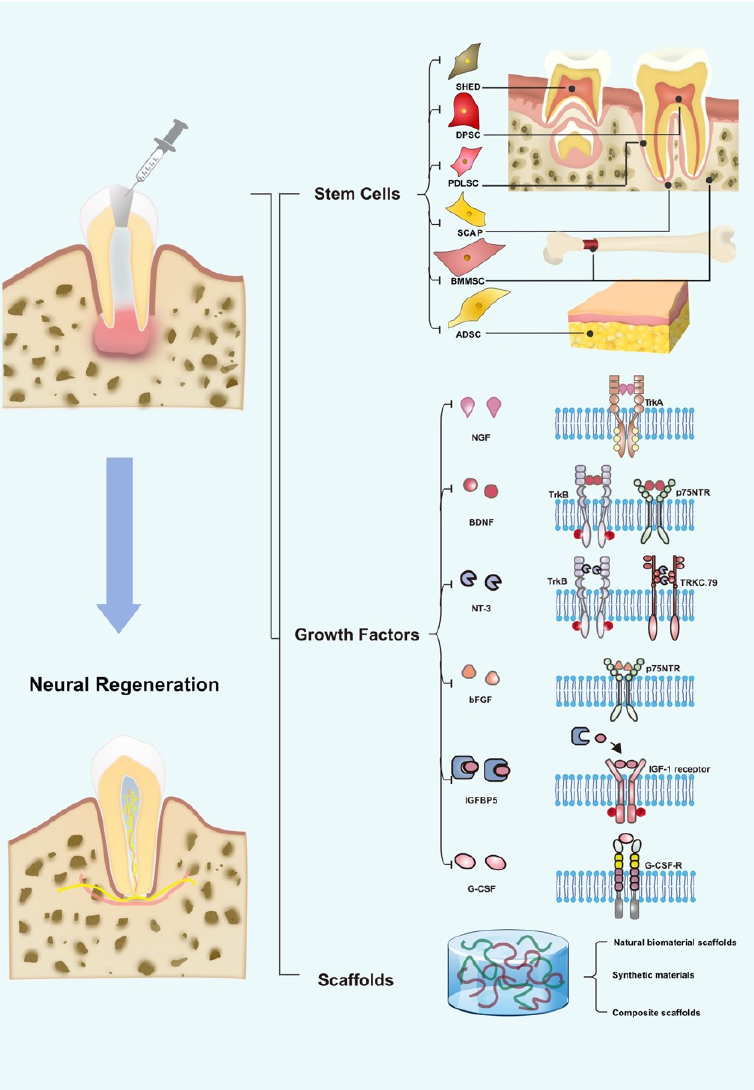
Figure 2. Stem cells, growth factors, and scaffolds in neural regeneration in RET. SHED: stem cell from human exfoliated deciduous teeth; DPSC: dental pulp stem cell; SCAP: apical papilla stem cell; PDLSC: periodontal ligament stem cell; BMMSC: bone marrow mesenchymal stem cell; ADSC: adipose-derived stem cell; NGF: nerve growth factor; BDNF: brain-derived neurotrophic factor; NT-3: neurotrophin-3; bFGF: basic fibroblast growth factor; IGFBP5: insulin-like growth factor-binding protein 5; G-CSF: granulocyte colony-stimulating factor.